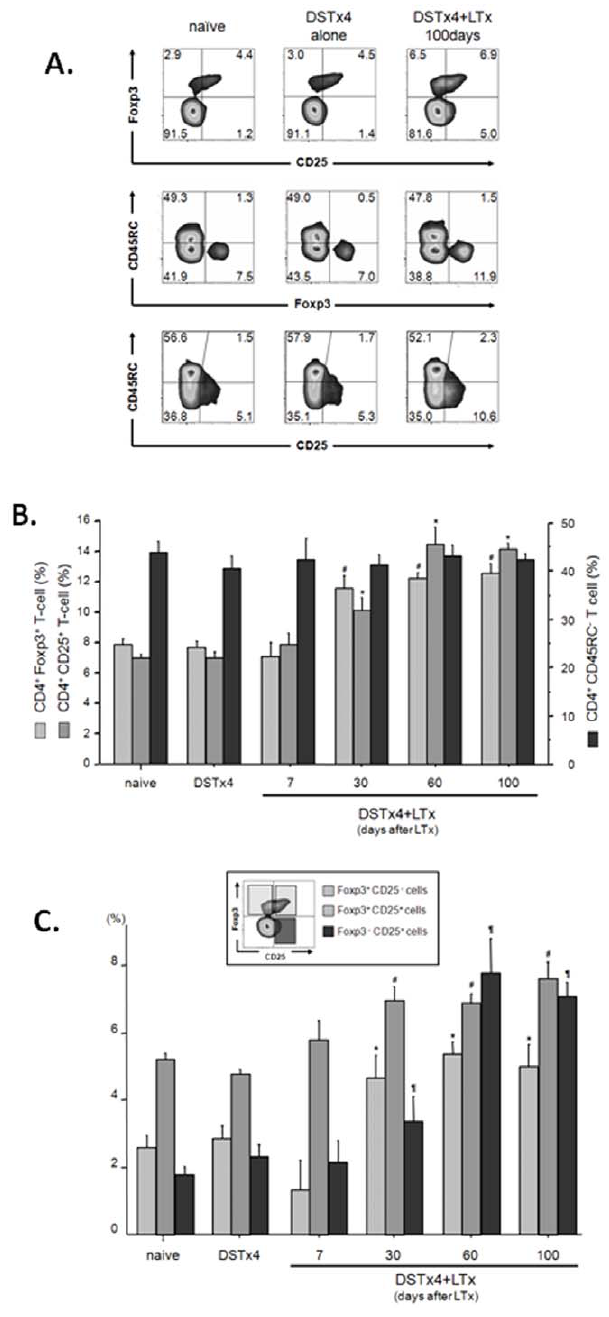
Figure 4. Alterations in different CD4 + populations in spleens obtained from LEW rats subjected to DST in the absence or presence of LTx. (A) Representative flow cytometric analysis of splenocytes harvested from either naı¨ve, DSTx4 alone or DSTx4 + LTx rats 100days after LTx. Cells are gated on CD3 + CD4 + T-cells. Isotype- matched control antibodies were used to set all gates. (B) Percentages of Foxp3 + , CD25 + or CD45RC 2 T-cells within the CD4 + T-cell population in spleens from naive, DST treated or DSTx4 + LTx rats. (C) Percentages of Foxp3 + CD25 2 , Foxp3 + CD25 + or Foxp3 2 CD25 + T-cells within the CD4 + T- cell population in spleens from naı¨ve, DST treated or DSTx4 + LTx rats. The results are expressed as mean 6 SE from at least three individual experiments for each group. * # " P , 0.05 compared with correspond- ing population in naı¨ve group.